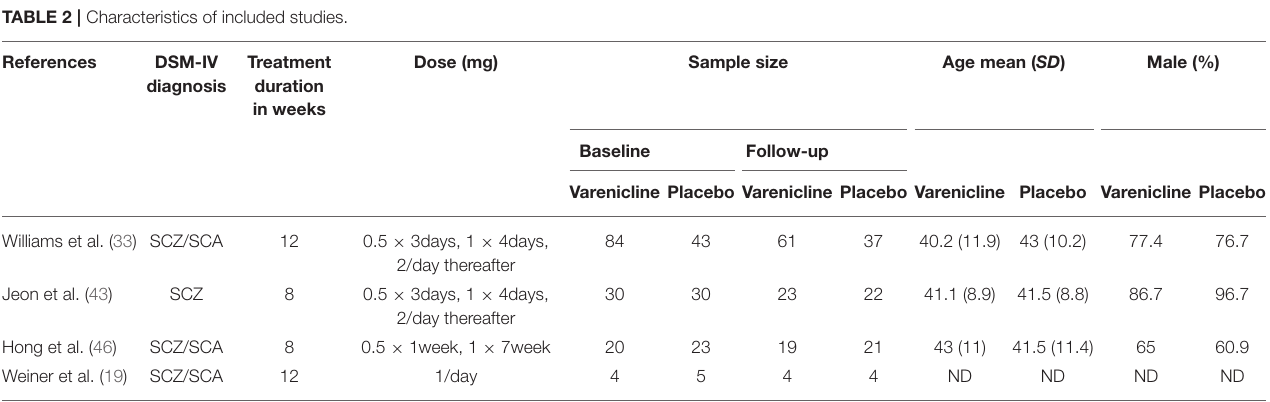
TABLE 2 | Characteristics of included